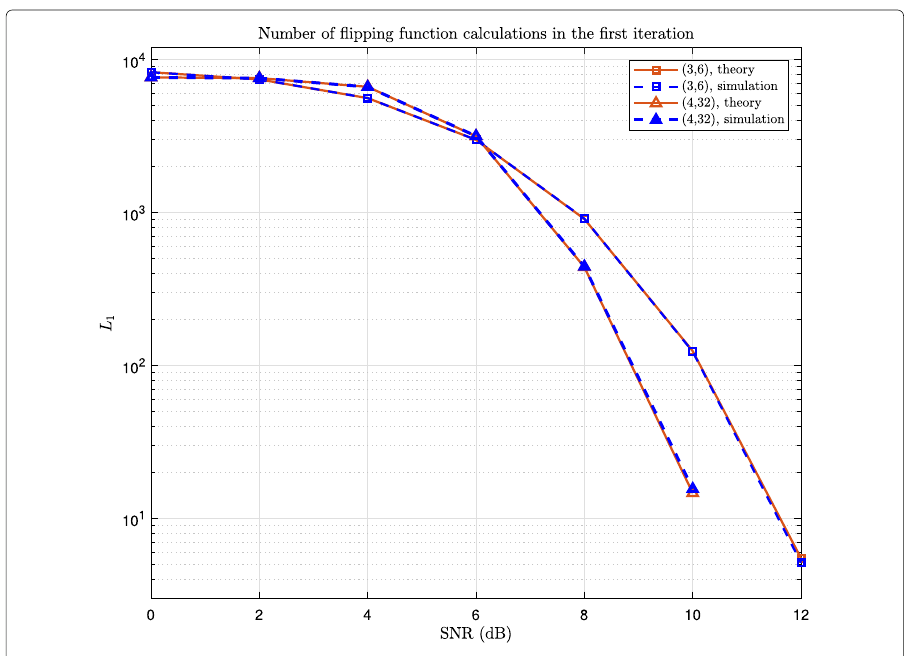
Fig. 2 L 1 versus SNR for the (3,6) and (4,32)-regular LDPC